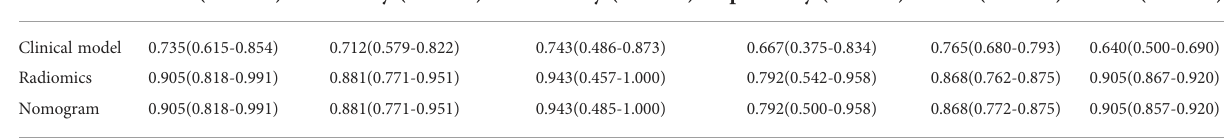
TABLE 3 Diagnostic performance of clinical model, radiomics, and nomogram in classi fi cation between early-stage type I and II